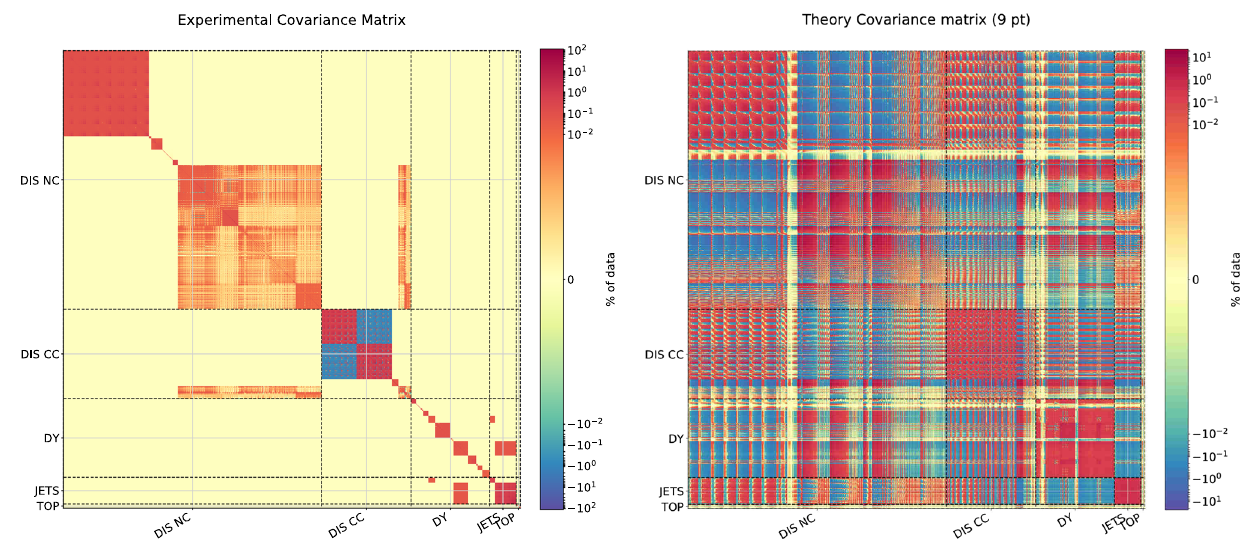
Fig. 6 Comparison of the experimental C ij (left) and the theoretical S ij (right)covariancematrices,thelatterevaluatedusingthe9-pointpre- scription. All entries are normalized to the central experimental value.